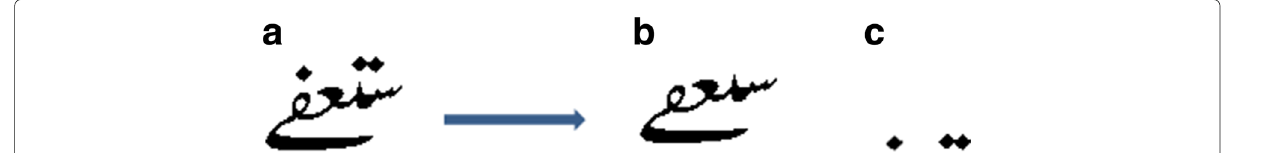
Fig. 1 a Complete ligature. b Primary/main ligature. c Secondary ligatures (dot/diacritic)